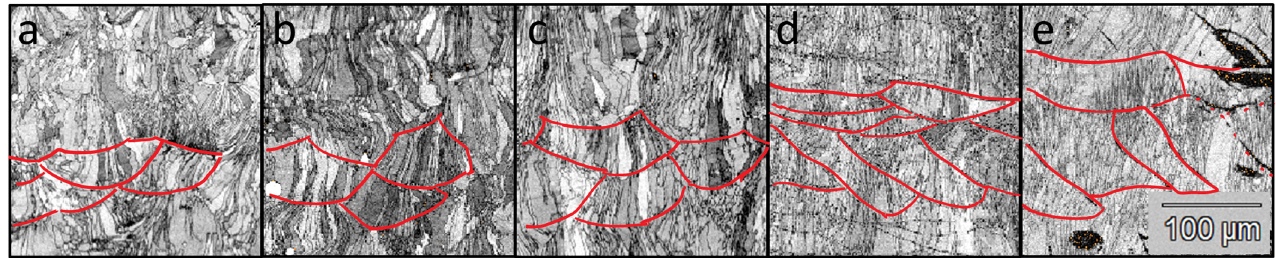
Figure 7. EBSD analyses on xz section of NiTi specimens; pattern quality maps, with outlined some representative melt pool boundaries ( a – e ); increasing fluence.